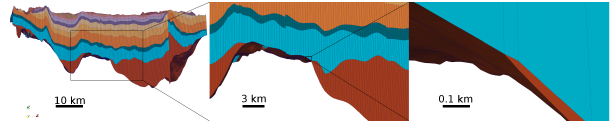
Figure 6. Mesh elements at non-continuous geological units, ver- tical cross section A–B (see Fig. 1) through the GOCAD model at different magnification levels, vertical exaggeration 20 given in Fig. 3.